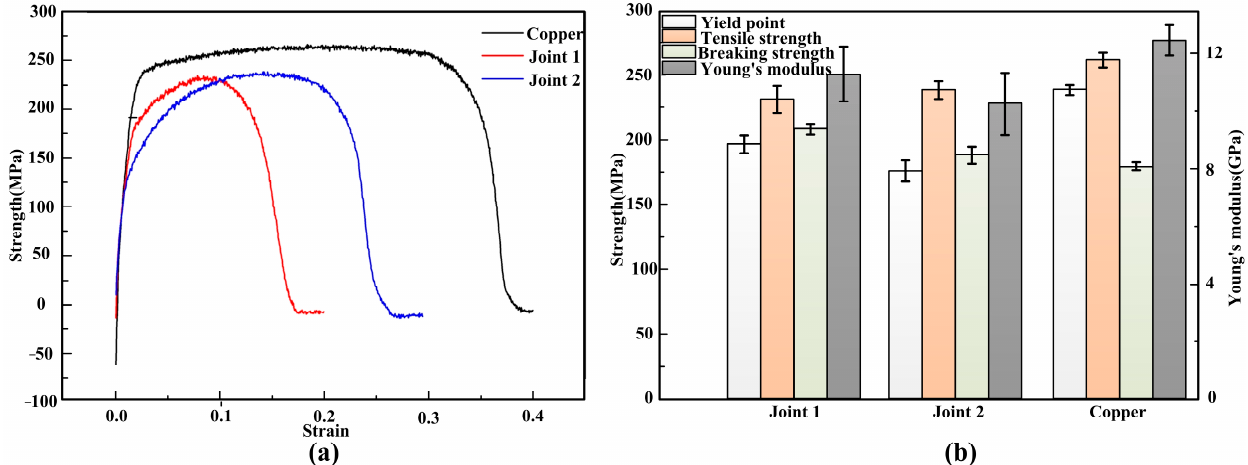
Figure 13. ( a ) The engineering stress–strain curves and ( b ) yield point, tensile strength, breaking strength and Young’s modulus of different joints.